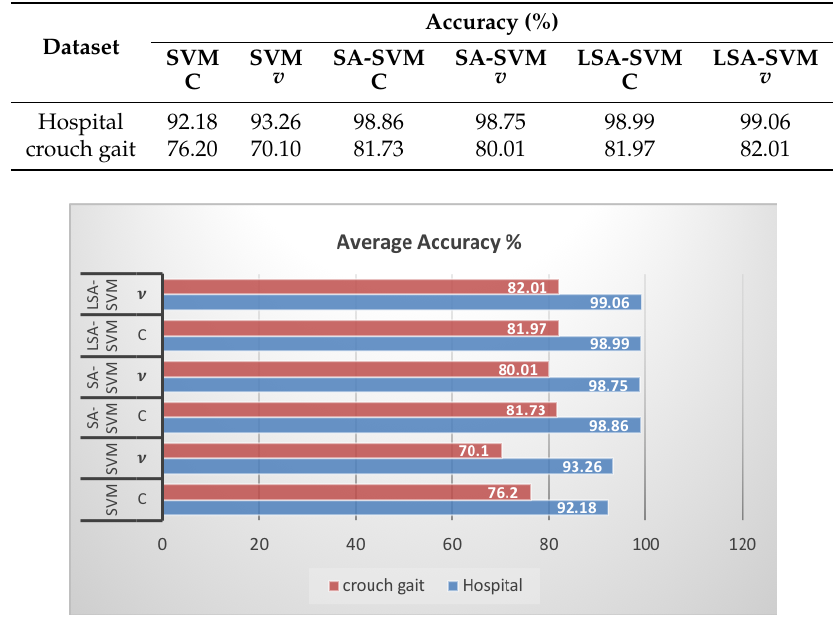
Figure 13. The average classification accuracy of LSA-SVM across two datasets using five-fold cross-validation compared with other